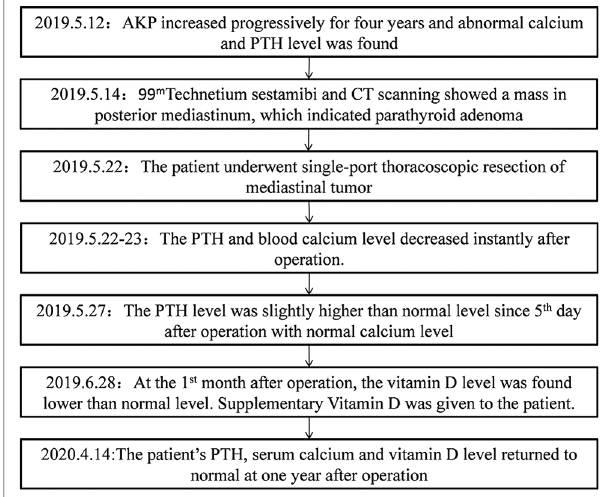
FIGURE 4 | The timeline of clinical interventions of this patient